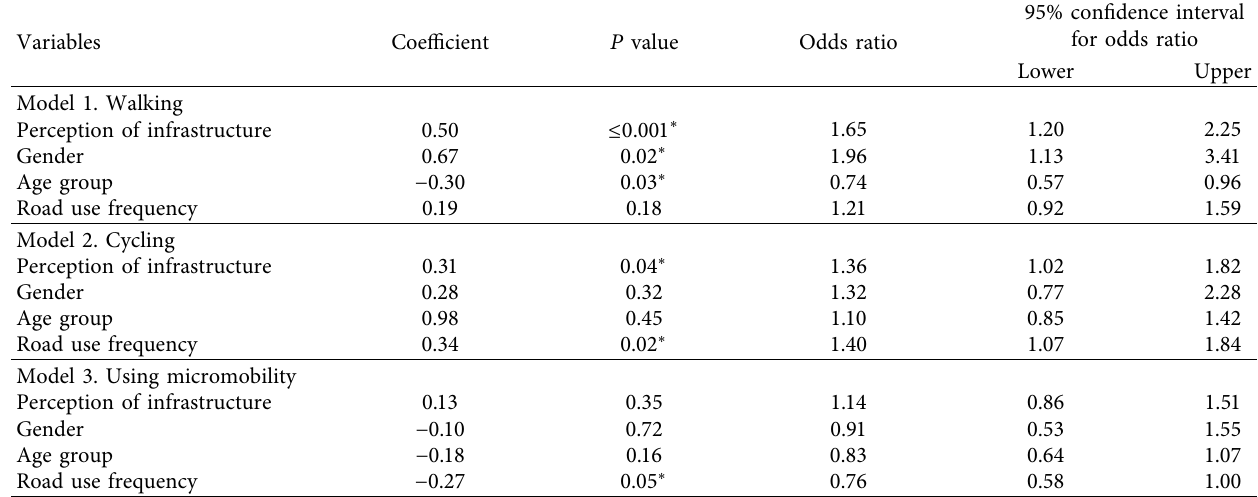
Table 3: Ordered logit models for safety